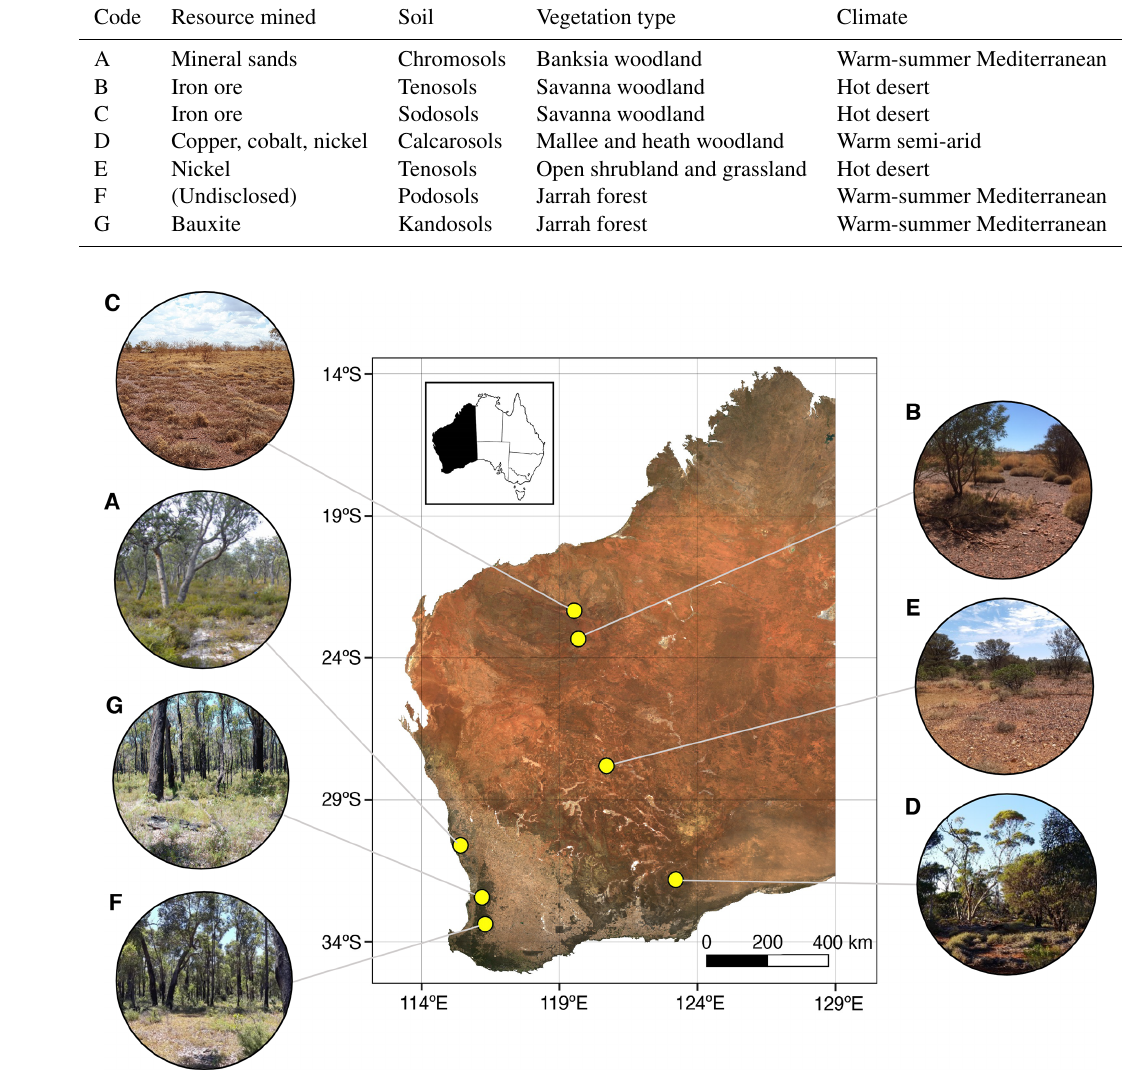
Figure 1. Location of mine sites within Western Australia from which soil samples were collected for spectroscopic analysis. Soils were collected from a variety of vegetation types in different climatic regions, including from (a) a mineral sands mine within banksia woodland in a warm-summer Mediterranean region, (b, c) two iron ore mines within savanna woodland in the hot desert region, (d) a copper–cobalt– nickel mine within mallee woodland in the warm semi-arid region, (e) a nickel mine within open shrubland and grassland in the hot desert region, and (f, g) a bauxite mine and another undisclosed commodity mine both within jarrah forest in the warm-summer Mediterranean region. Inset: location of Western Australia within